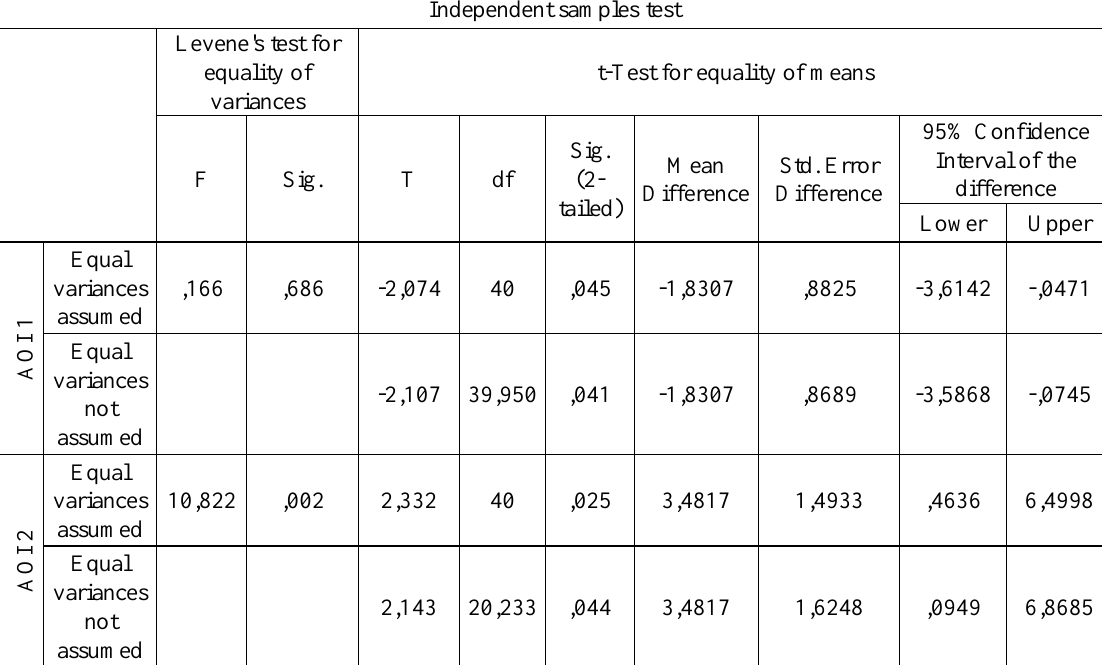
Table 2: Independent Sample